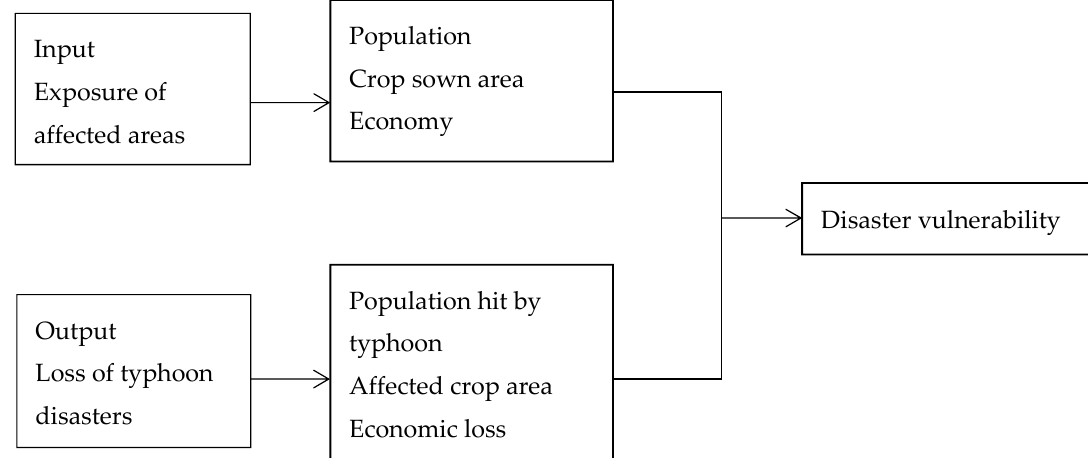
Figure 1. Input–output analysis of vulnerability to typhoon disasters.